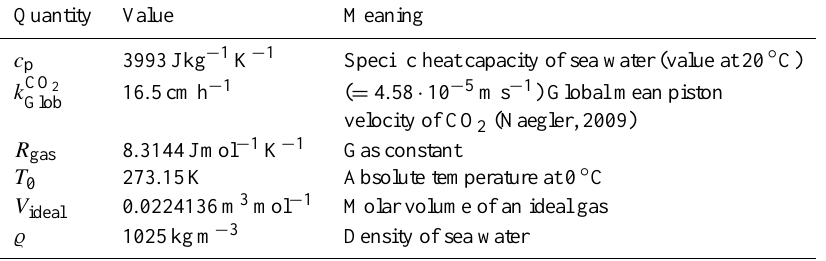
Table 3. Physical constants, and geophysical quantities assumed constant.